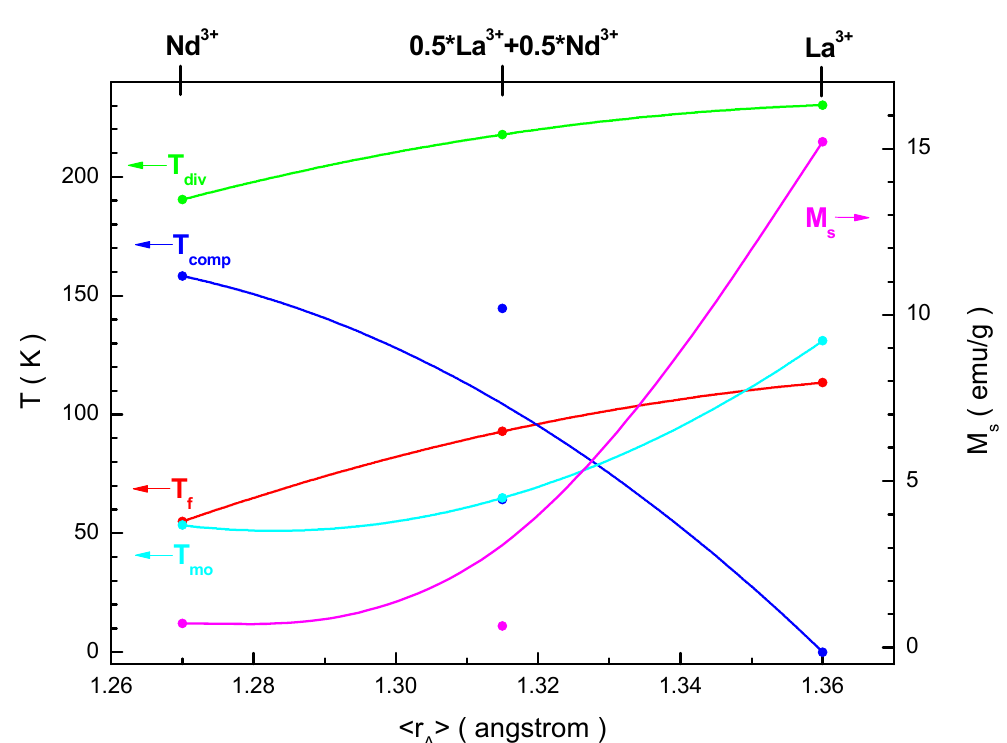
Figure 11. Dependences of the critical temperatures, such as the T f freezing (red line), T div divergence (green line), T mo magnetic ordering (cyan line), T comp compensation (blue line) temperatures (right axis) and M s spontaneous magnetization (magenta line) (left axis) on the <r A > average ionic radius of the A-sublattice of perovskite structure for the investigated samples.